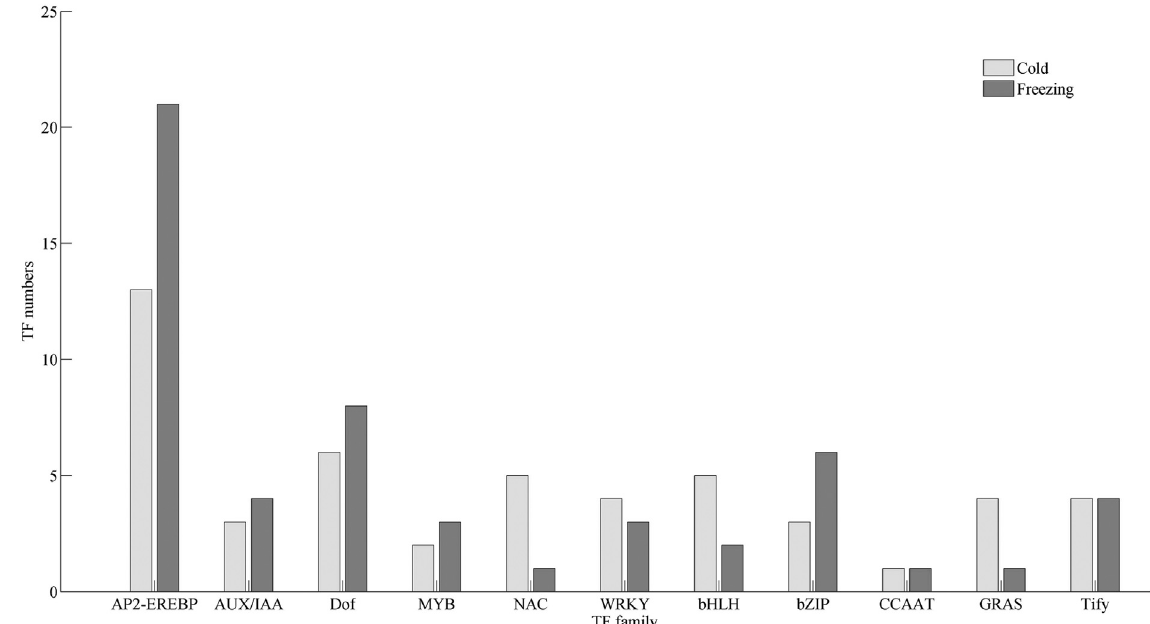
Figure 6 - Distribution of transcription factors differentially expressed in response to cold and/or freezing stress by gene